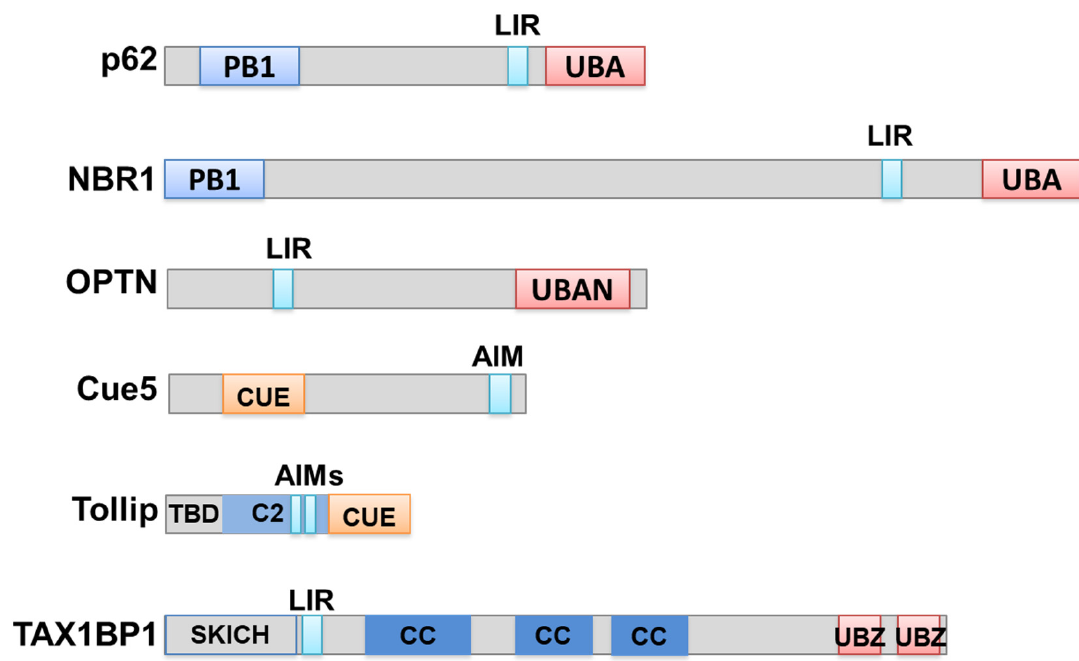
Figure 2. Scheme of functional domains of autophagy receptors in aggrephagy. Essential domains are featured on the receptor proteins. Features: PB1, Phox and Bem1 domain; LIR, LC3-interacting region; UBA, ubiquitin-associated domain; UBAN, ubiquitin-binding domain in ABIN proteins and NEMO; CUE, coupling of ubiquitin conjugation to ER degradation domain; AIM, Atg8-interacting motif; TBD, Tom1-binding domain; C2, C2 domain; SKICH, SKIP carboxyl homology domain; UBZ, ubiquitin-binding zinc finger.